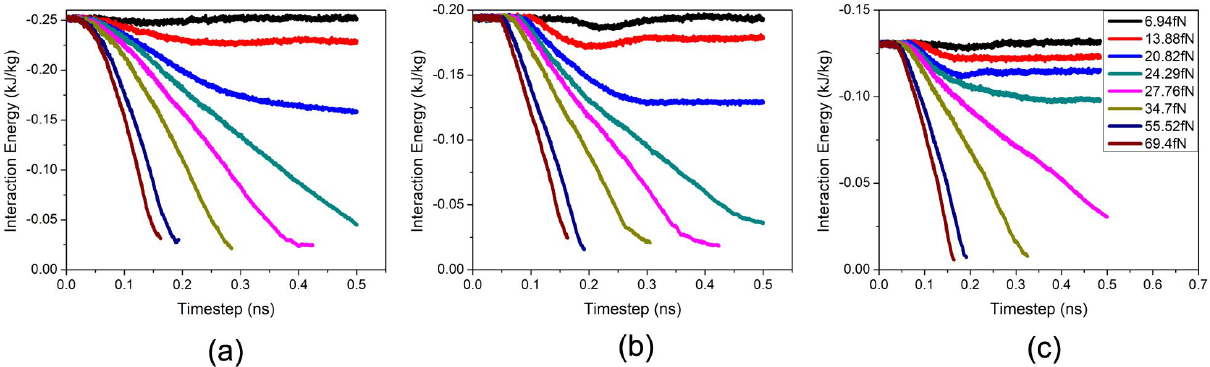
Figure 7: The interaction energies between the CNT and the polymer chains as a function of time during the constant force pullout MD